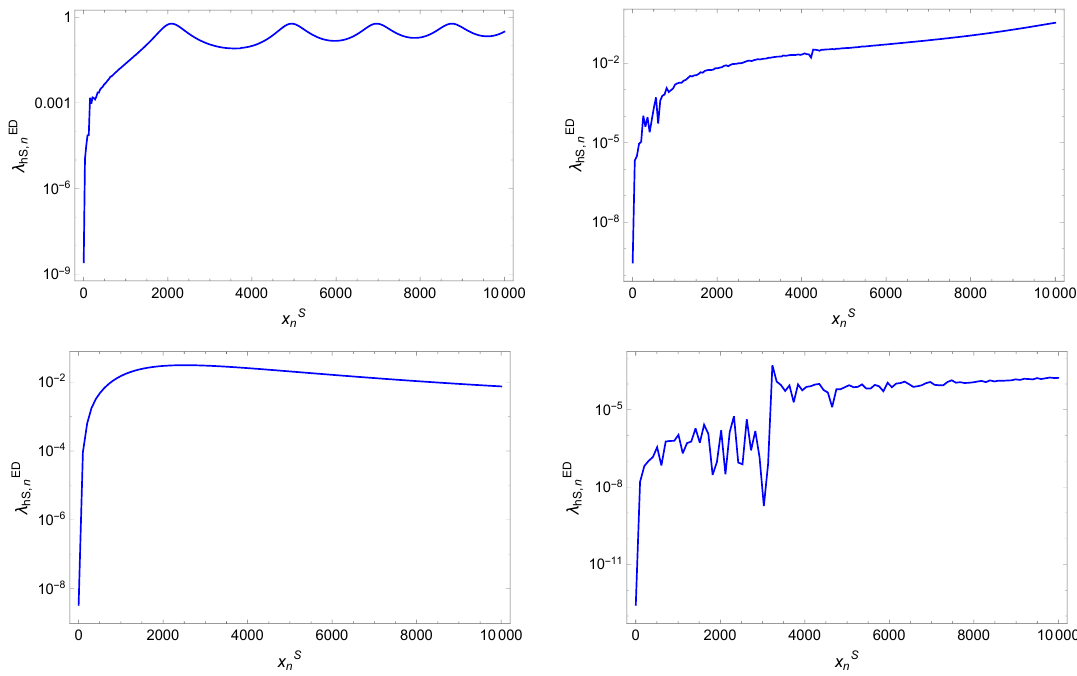
Figure 7 . Higgs portal couplings as a function of x S for BM I (top left), BM II (top left), BM III (bottom left) and BM IV (bottom right) as described